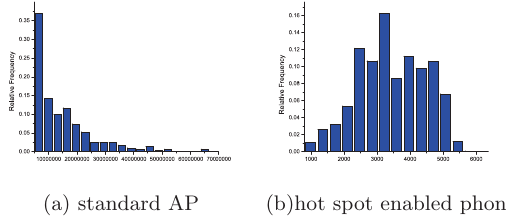
Figure 5: RTT histogram for standard AP and phone hot spots